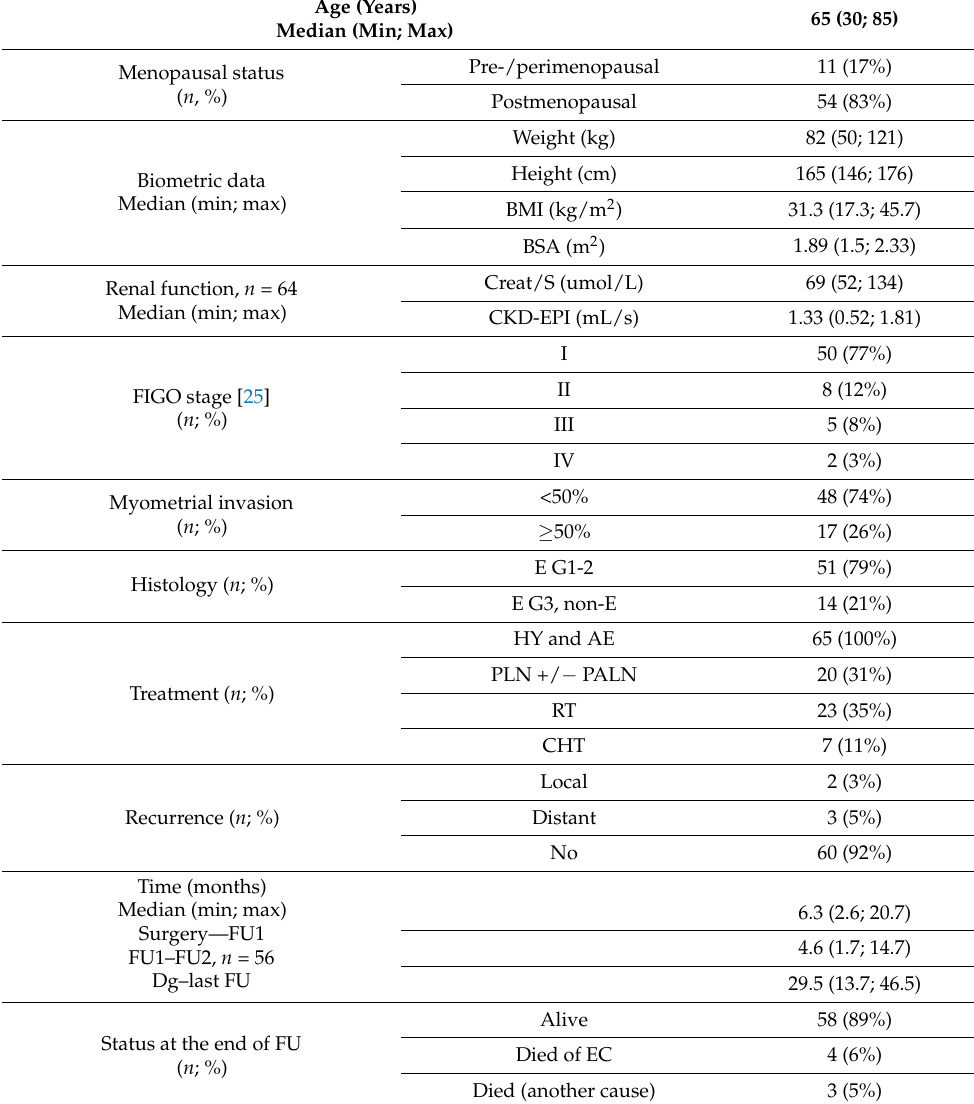
Table 1. Characteristics of endometrial cancer